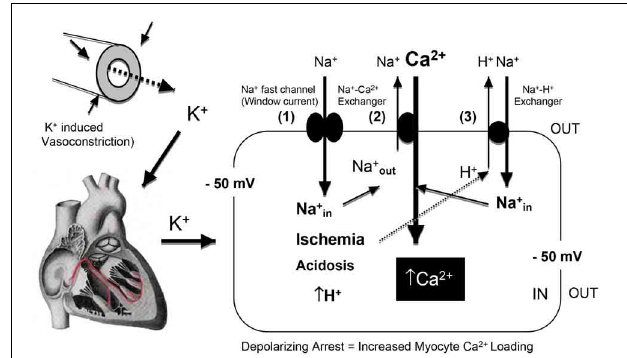
FIGURE 4 | A schematic of the effect of hyperkalemia and prolonged myocardial membrane depolarization on Na + entry through the “window current” and the net influx of Ca 2 + into the myocardial cell via the reversal of the Na + /Ca 2 + exchanger [3Na + ions are extruded in exchange for 1 Ca 2 + entry (Bers and Despa, 2009) at a membrane potential of − 50mV (Baczko et al., 2003)]. Global or regional ischemia and metabolic acidosis impact further on Ca 2 + loading, with increases in intracellular H + further activating the Na + /H + exchanger (Avkiran, 2001) resulting in 1Na + ion being exchange for 1 H + ion. The diagram was adapted from Bers and colleagues (Bers et al., 2003; Bers and Despa,